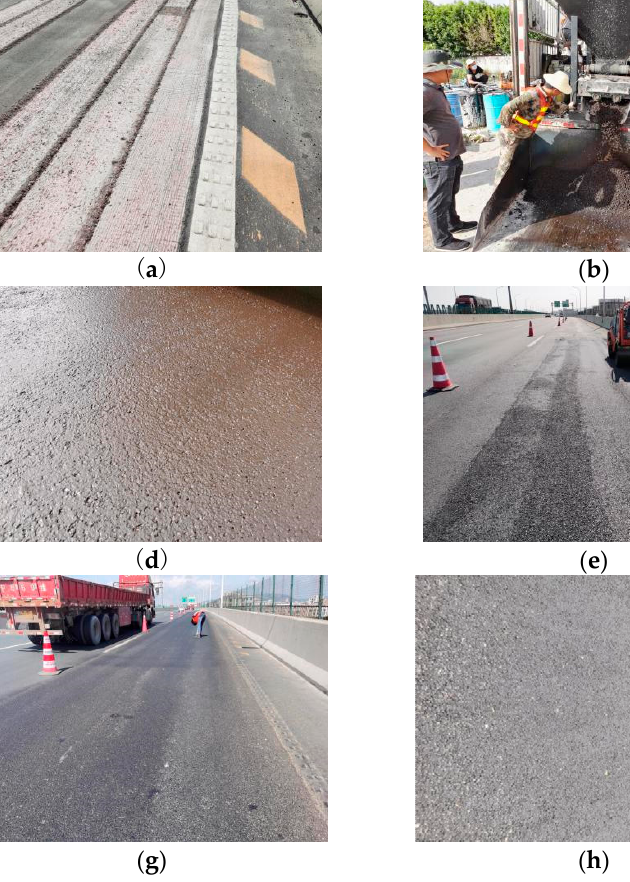
Figure 10. Application of HCUP: ( a ) original pavement milling; ( b ) mixture production; ( c ) paving construction; ( d ) paving surface details; ( e ) roller construction; ( f ) rolled surface details; ( g ) pavement after six months; ( h ) pavement details after six months.